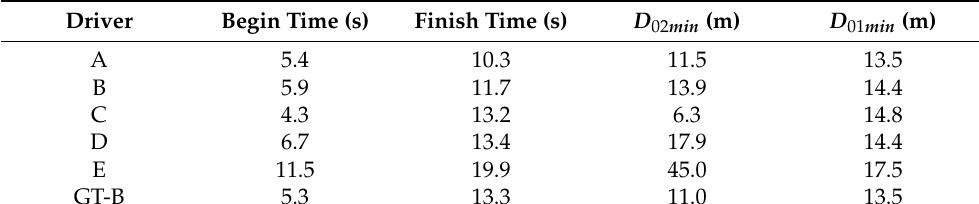
Table 7. Driving parameters of different drivers under Case I.